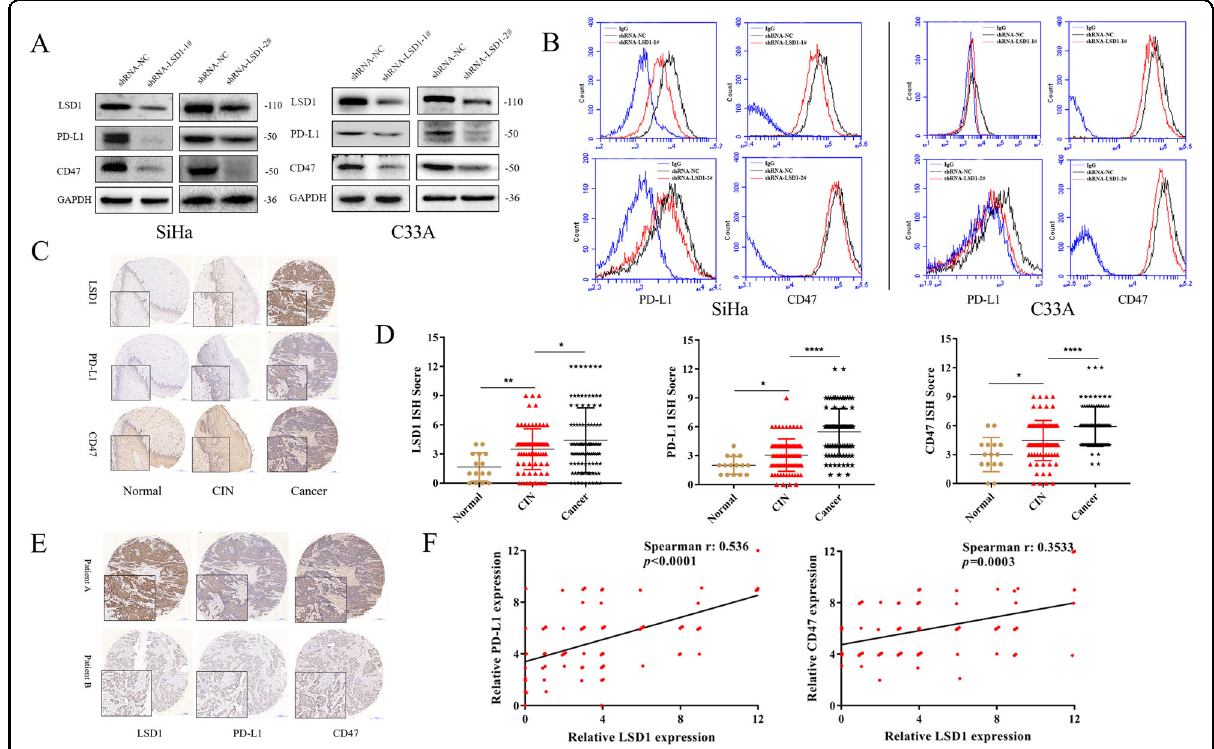
Fig. 1 LSD1 is positively correlated with CD47/PD-L1 in cervical cancer cells and tissues. The positive correlation between LSD1 and CD47/PD- L1 expression was demonstrated using western blotting ( A ) and fl ow cytometry ( B ). Both IHC staining intensity ( C ) and IHC score ( D ) for LSD1, as for CD47/PD-L1, showed a steady increase during the progression of cervical cancer. IHC staining intensity ( E ) and Spearman correlation analysis ( F ) also con fi rmed the signi fi cant correlation between LSD1 and CD47/PD-L1 expressionfrom a clinical perspective. The western blotting and fl ow cytometric processes were repeated three times. * p < 0.05; ** p < 0.01; **** p <